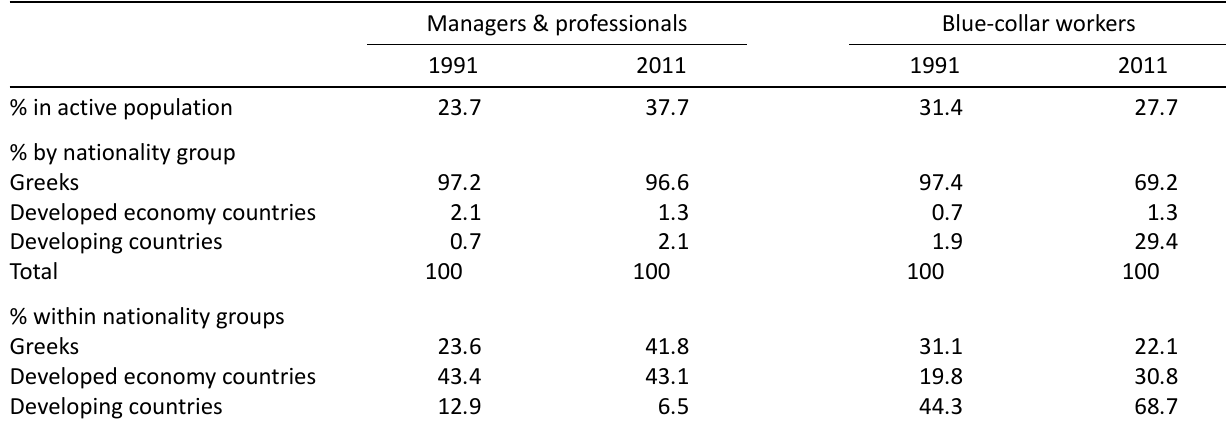
Table 1. Share of managers and professionals and blue-collar workers in the active population and distribution by nation- ality group in the Athens metropolitan area